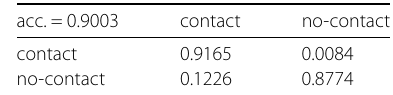
Table 6 Confusion matrix with accuracy of the BiLSTM-RSSI for event reconstruction acc. = 0.9003